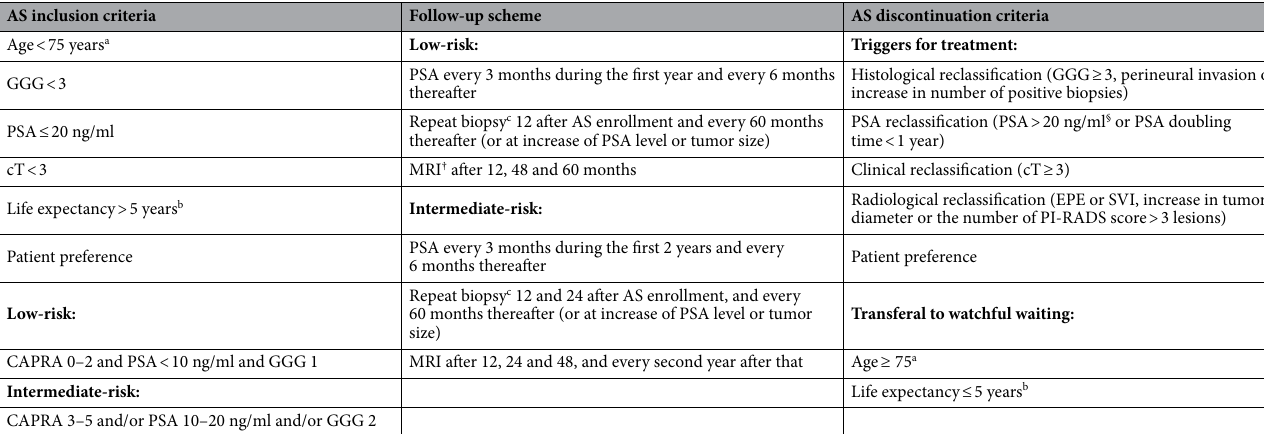
Table 1. Active surveillance protocol at Vestfold Hospital Trust. AS active surveillance, CAPRA cancer of the prostate risk assessment, EPE extraprostatic extension, GGG Gleason grade group, MRI magnetic resonance imaging, PSA prostate-specific antigen, SVI seminal vesicle invasion. a Changed from 75 to 80 years in 2014. b Based on Charlson comorbidity index. c Systematic and/or MRI-targeted. d On at least two consecutive